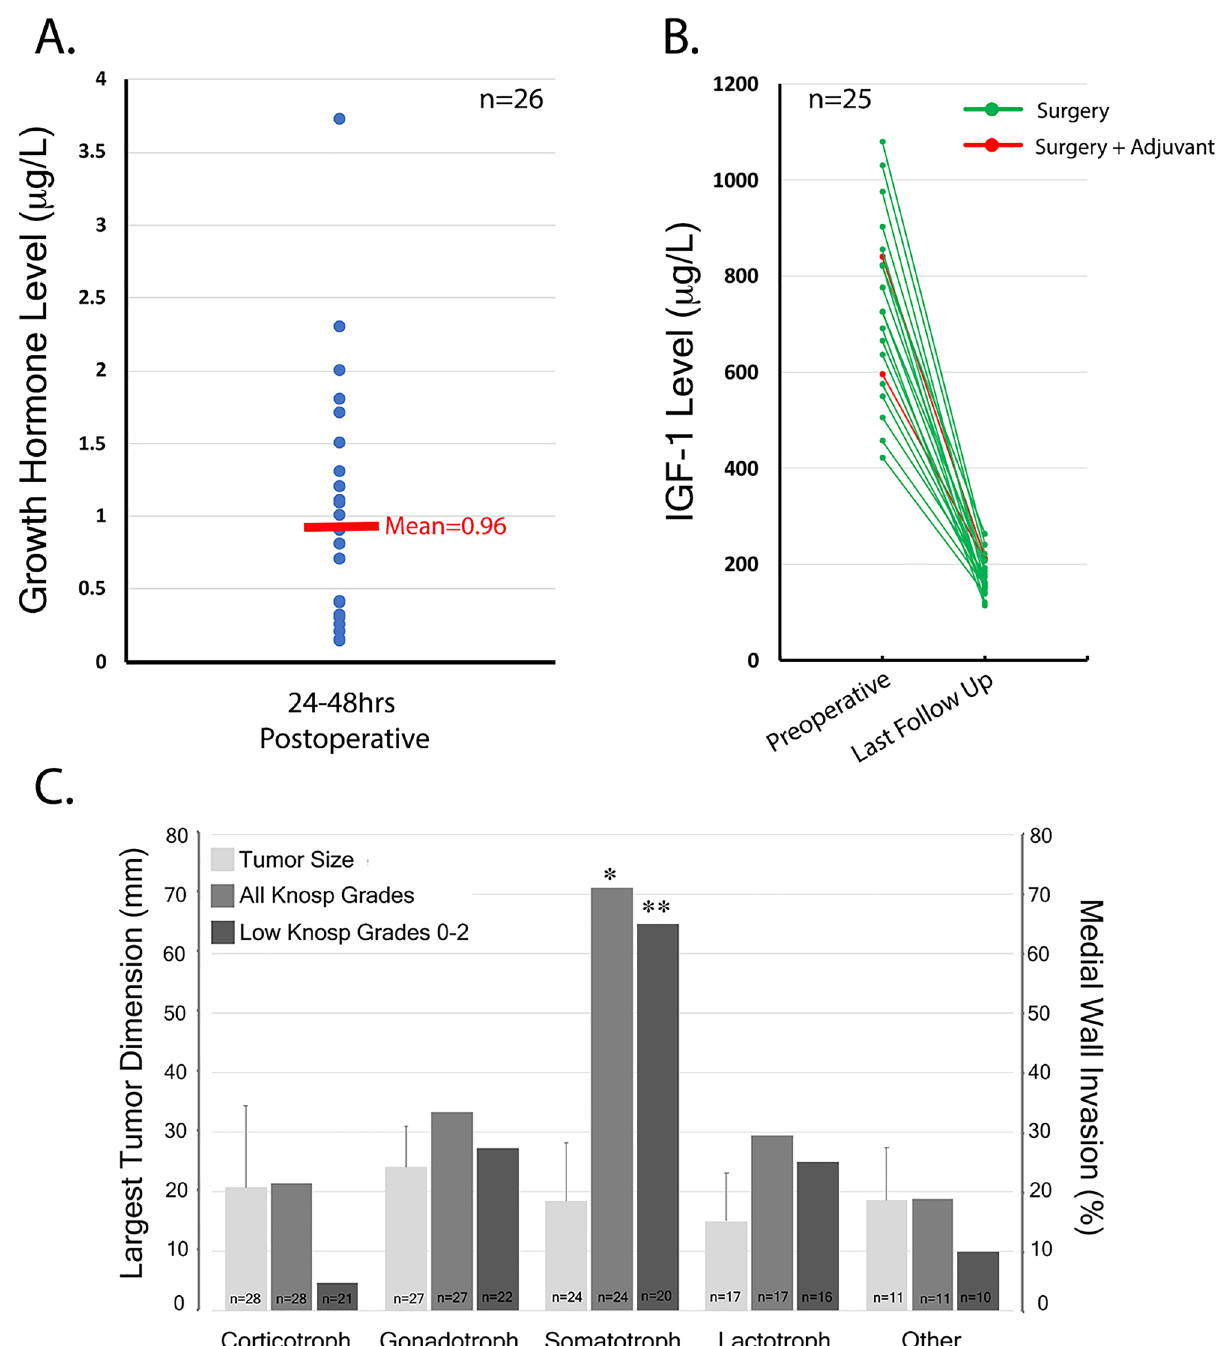
Figure 4. ( A ) Mean postoperative GH nadir 24-48hrs after surgical resection in acromegaly cohort (n=26) ( B ) Preoperative and postoperative (3-12 months) IGF-1 levels in acromegaly cohort (n=25), two-tailed unpaired t-test demonstrates statistically significance between preoperative and postoperative IGF-1 levels ( p <0.0001) ( C ) A graphical visual summary of the important findings from Table 1, 2 and 3 and demonstrates that somatotroph adenomas have a predilection to invade the cavernous sinus irrespective of tumor size. Using a Chi square test, we demonstrate that the effect that somatotrophs have on predicting cavernous sinus invasion was present across all Knosp grades 0-4 (* p <0.02) and even present across low Knosp grades 0-2 (** p